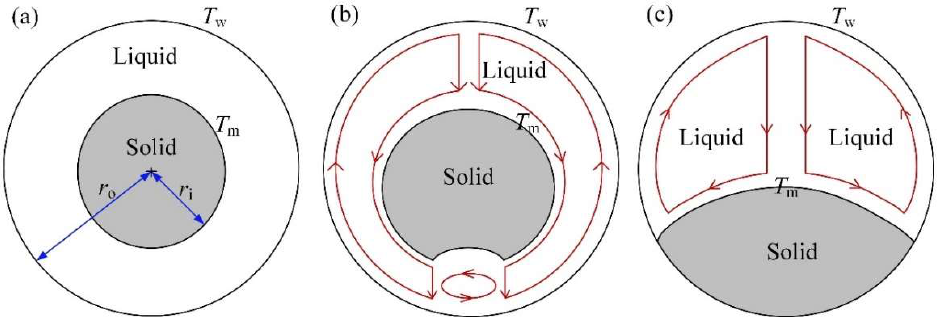
Figure 1. Schematic diagrams of: ( a ) equivalent thermal conductivity model, ( b ) constrained melting, and ( c ) unconstrained melting.